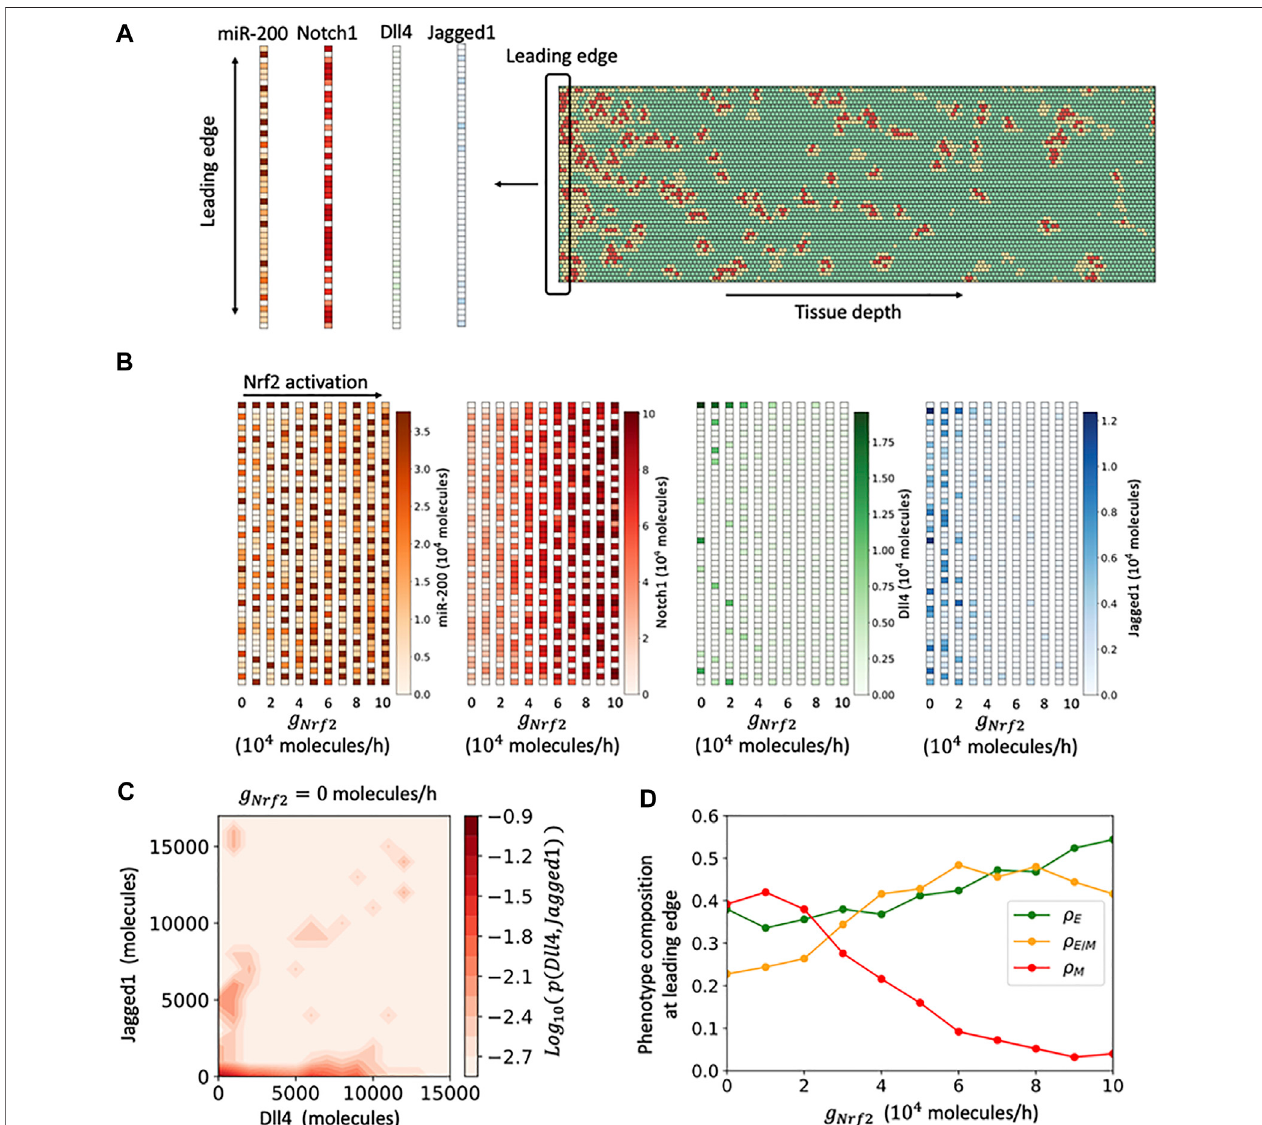
FIGURE 5 | Analysis of the leading edge by the multicell model. (A) To conduct leading edge analysis, the expression of miR-200, Notch, Dll4 and Jagged1 is analyzed in the leftmost layer of cells (i.e., the cell layer more exposed to EMT-inducing signal and thus comparable to the experimental leading edge). (B) Heatmap of expression levels for miR-200, Notch1, Dll4 and Jagged1 in the leading edge as a function of Nrf2 activation. Each column represents the lattice leading edge for a different level of Nrf2 production rate ( g Nrf 2 ). (C) Log-normalized probability to observe cells with varying levels of Dll4 and Jagged1 in the model ’ s leading edge under low Nrf2 induction. (D) Fraction of Epithelial, hybrid E/M, and Mesenchymal cells in the leading edge as a function of Nrf2 production rate ( g Nrf 2 ). For panels (C , D) , results are averaged over fi ve simulations starting from randomized initial conditions.